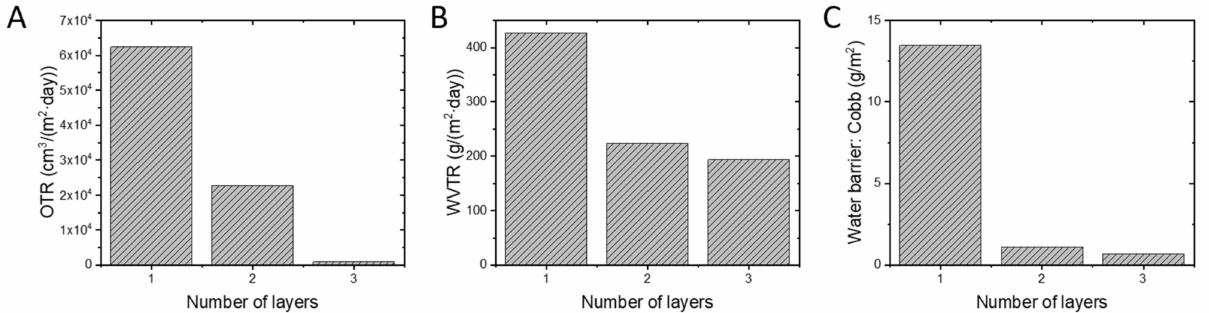
Figure 2. Barrier performance of ( A ) oxygen (OTR), ( B ) water vapor (WVTR) and ( C ) liquid water (Cobb) of coated paperboard with one, two or three coating